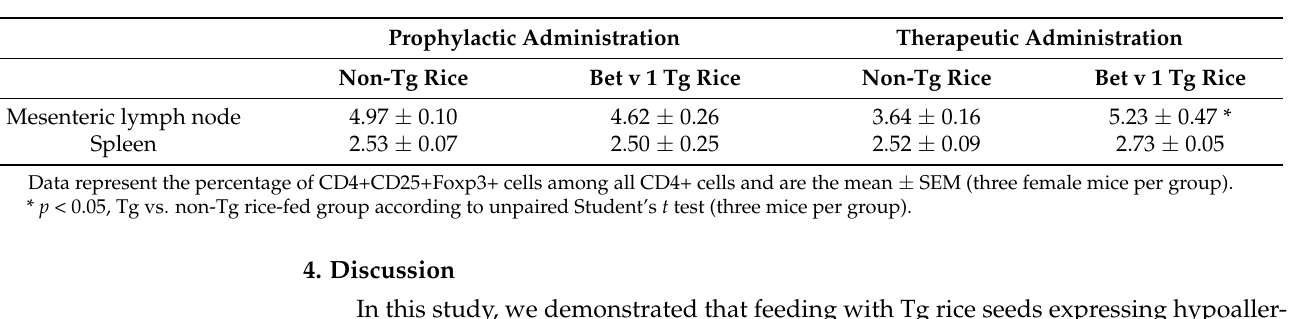
Table 3. Number of CD4+CD25+Foxp3+ Treg cells in mice fed Tg rice expressing native Bet v 1 or non-Tg rice.